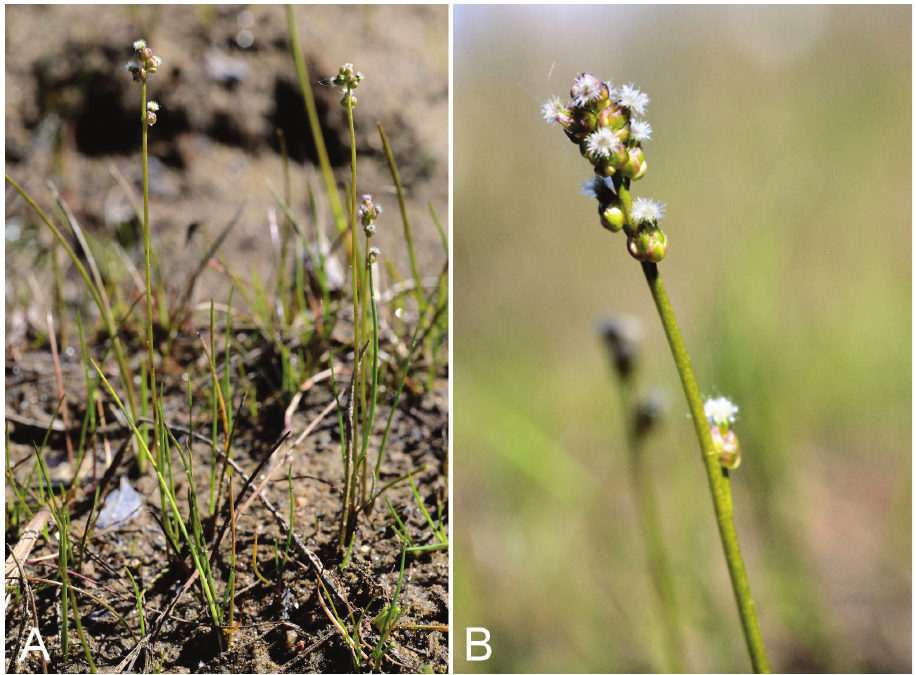
Figure 4. Triglochin palustris : A habit B inflorescence, Saarela et al. 2535 . Photographs by R.D.